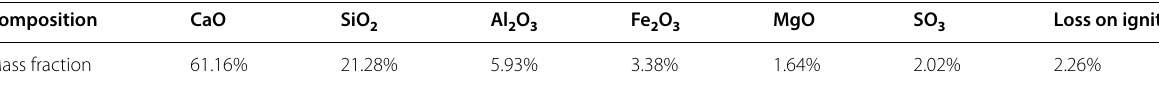
Table 2 Chemical compositions of the cement.